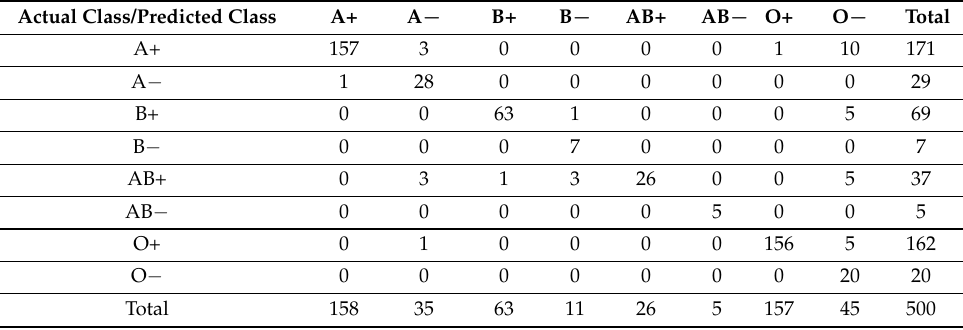
Table 13. Confusion matrix for the ORB algorithm over the 500 blood